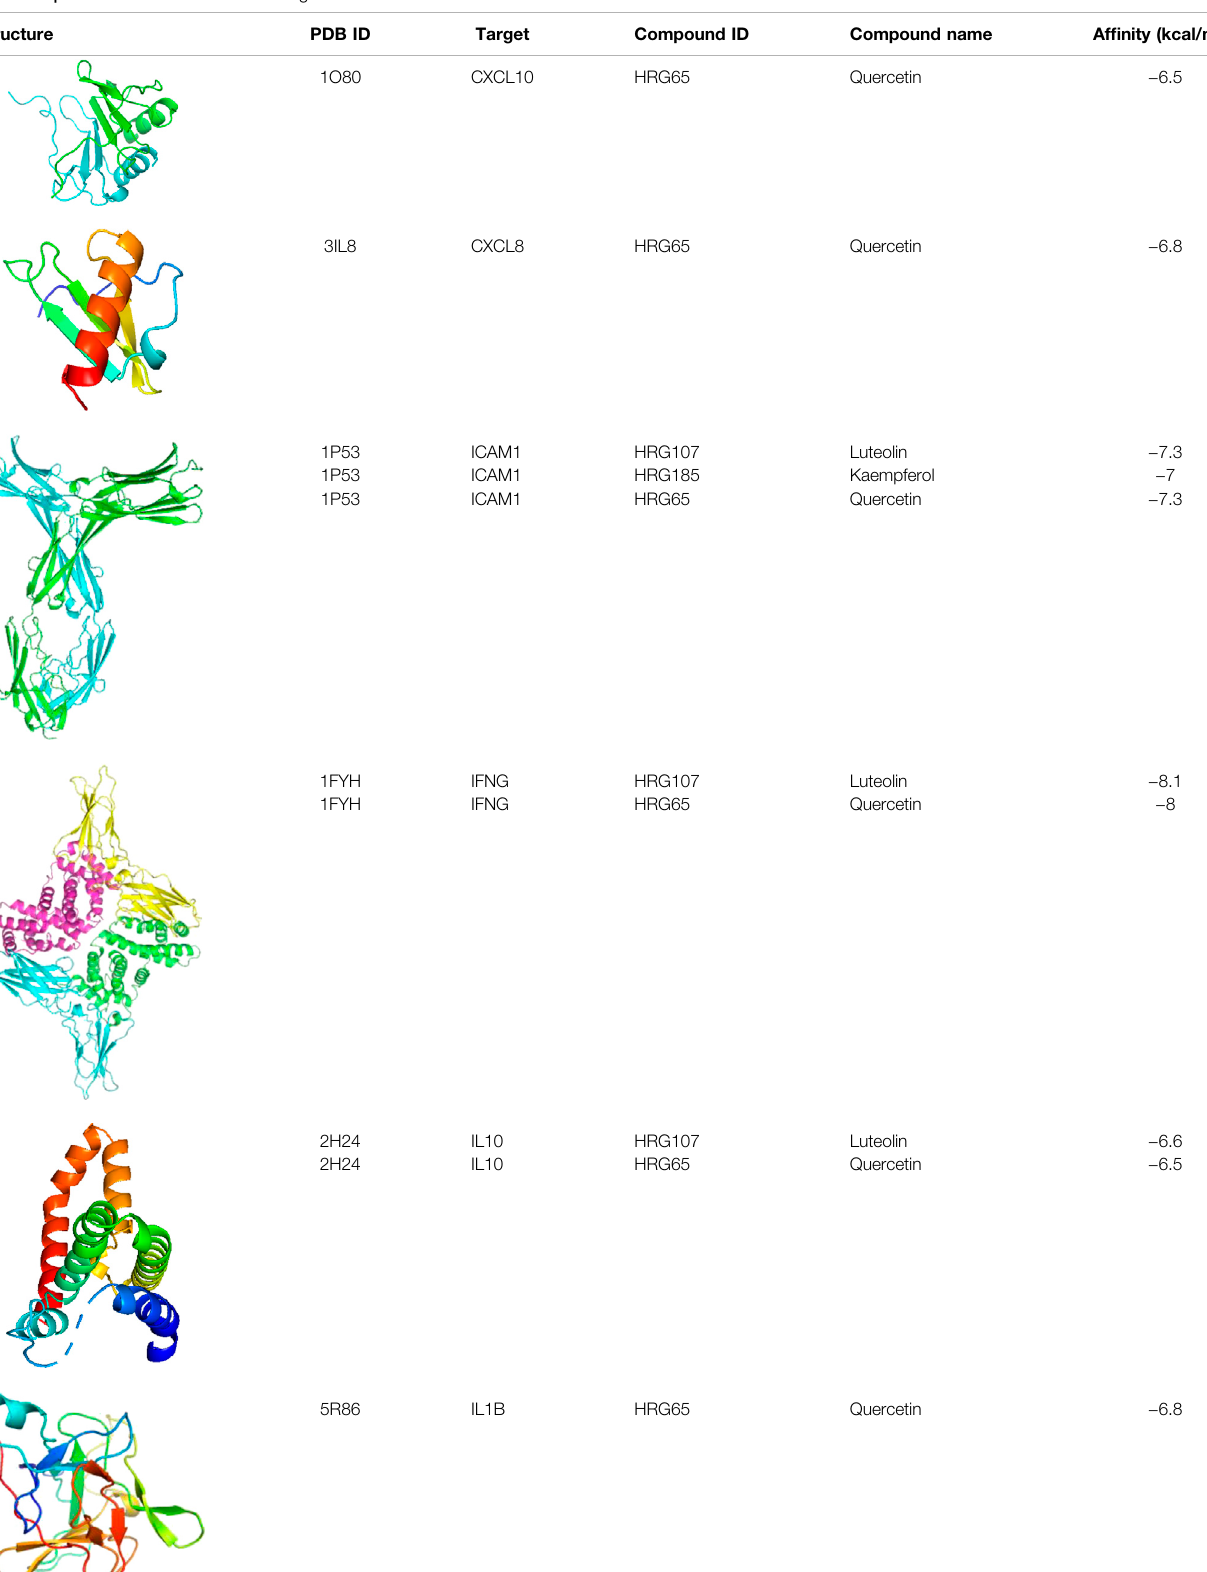
TABLE 4 | Information of molecular